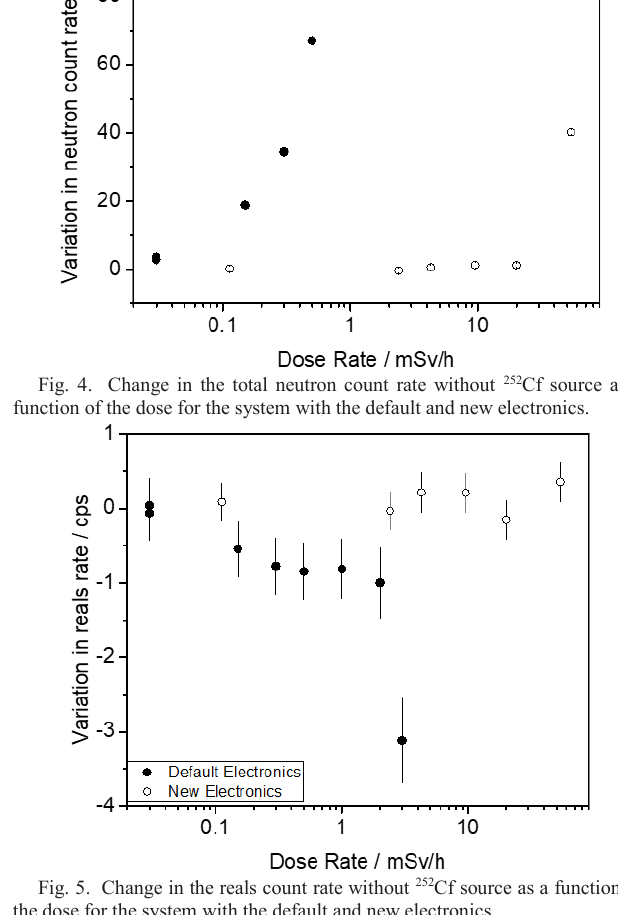
Fig. 2. Measured energy deposition spectrum. E d stands for deposited energy.